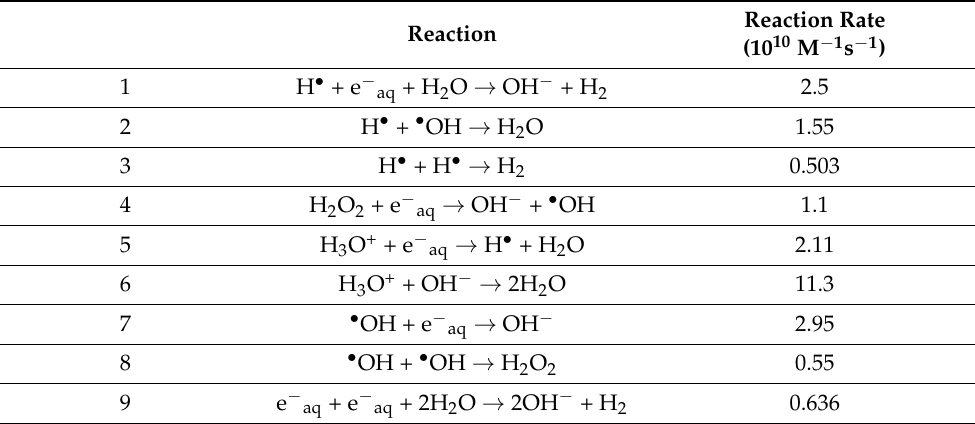
Table 3. The reactions and reaction rates [15] used in this work that apply at ambient temperature (25 ◦